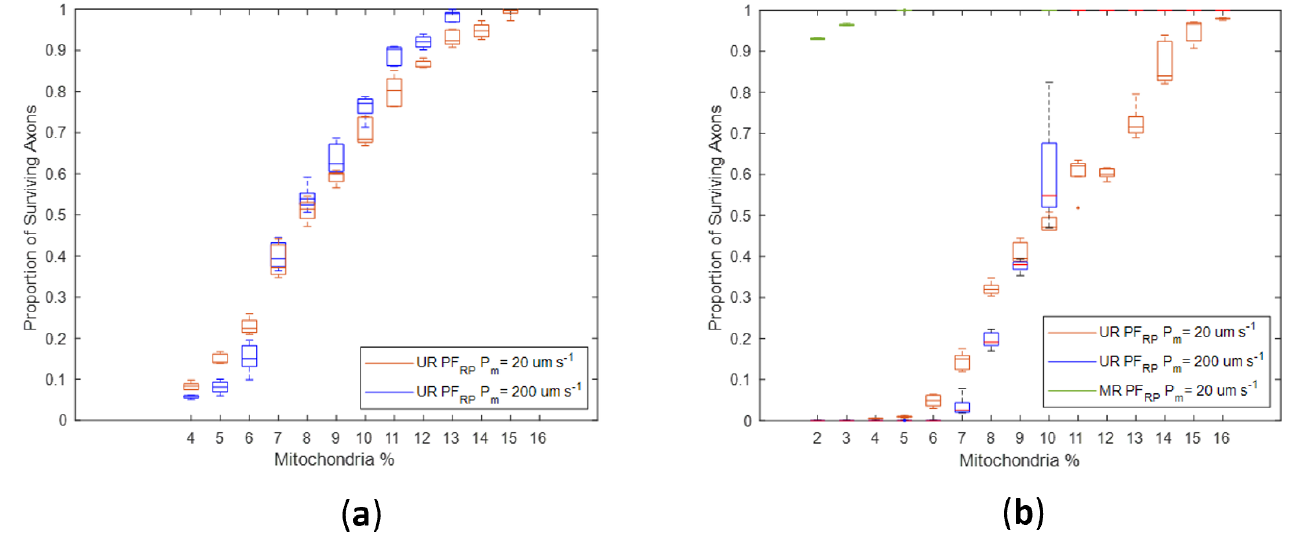
Figure 10. The proportion of surviving axons when the H 2 O 2 production rate in the Healthy state is lower or equal than in the Stress state (PF RP ) increases as the mitochondrial volume ratio (mito%) increases. Mito% varied between 4 and 20% for unmyelinated region simulations and 2 to 6% for myelinated region simulations. ( a ) The proportion of surviving axons as a function of mito%, when production rates in the Healthy and Stress states are equal; ( b ) The proportion of surviving axons as a function of mito% when the H 2 O 2 production rates in the Stress state are 30% higher than in the Healthy state.